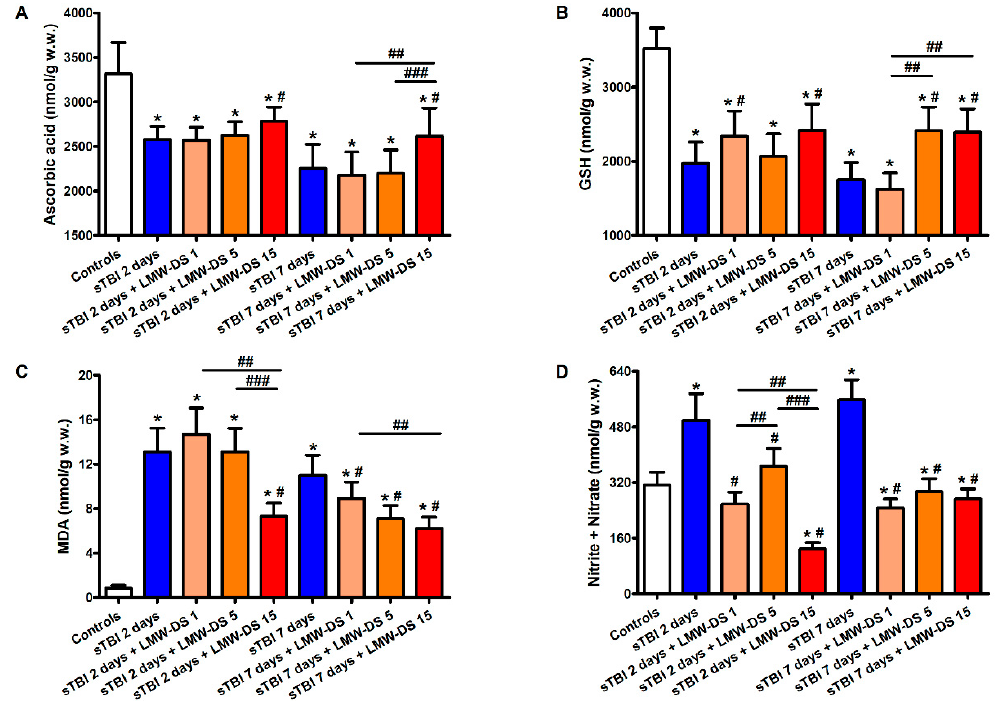
Figure 6. E ff ect of subcutaneous injection of increasing doses of LMW-DS (ILB ® ) on the cerebral concentration of the water-soluble low molecular weight antioxidants ascorbate ( A ) and GSH ( B ) and also of the biomarkers of oxidative / nitrosative stress, MDA ( C ) and nitrite + nitrate ( D ), which are valuable indicators of the nervous cell antioxidant defenses and ROS- and RNS-mediated damage. The parameters of interest were determined by HPLC on deproteinized cerebral homogenates at 2 and 7 days post-impact, both in untreated sTBI rats (TBI 2 days and TBI 7 days) and in rats receiving 1, 5, or 15 mg / kg b.w. LMW-DS (ILB ® ) administered 30 min after sTBI. Controls are represented by sham-operated rats. Values are the mean ± SD of 12 di ff erent animals and are expressed as nmol / g w.w. * Significantly di ff erent from sham-operated control rats, p < 0.05. # Significantly di ff erent from the corresponding time point of untreated sTBI rats, p < 0.05. ## Significantly di ff erent from LMW-DS 1, p < 0.05. ### Significantly di ff erent from LMW-DS 5, p <